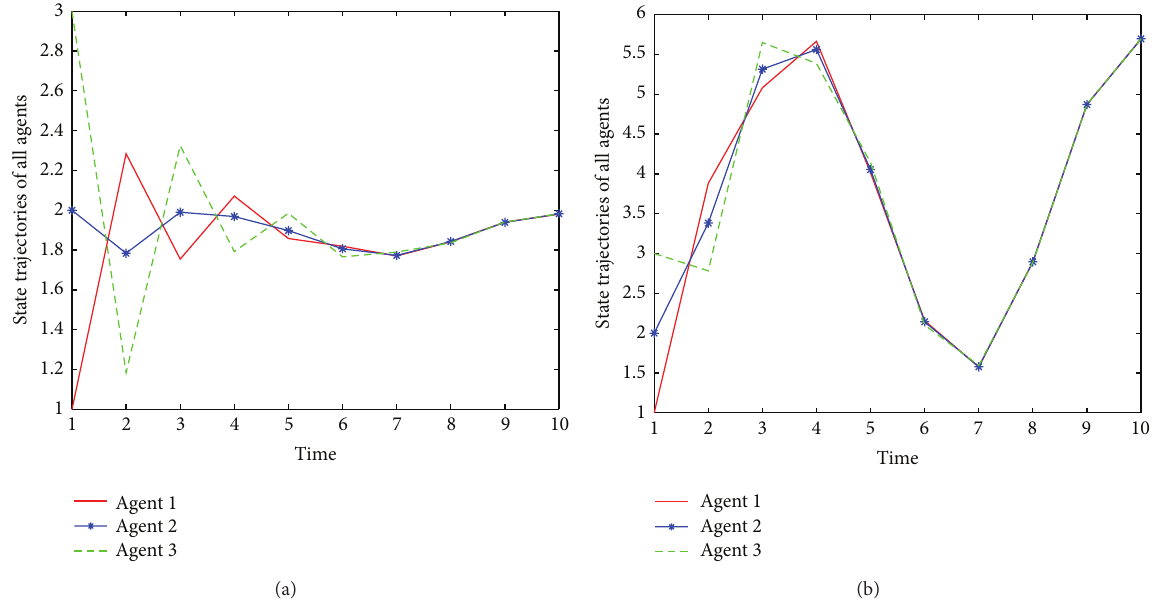
Figure 4: (a) State trajectories of all agents when 𝛾 = 0 . 1. (b) State trajectories of all agents when 𝛾 = 2.